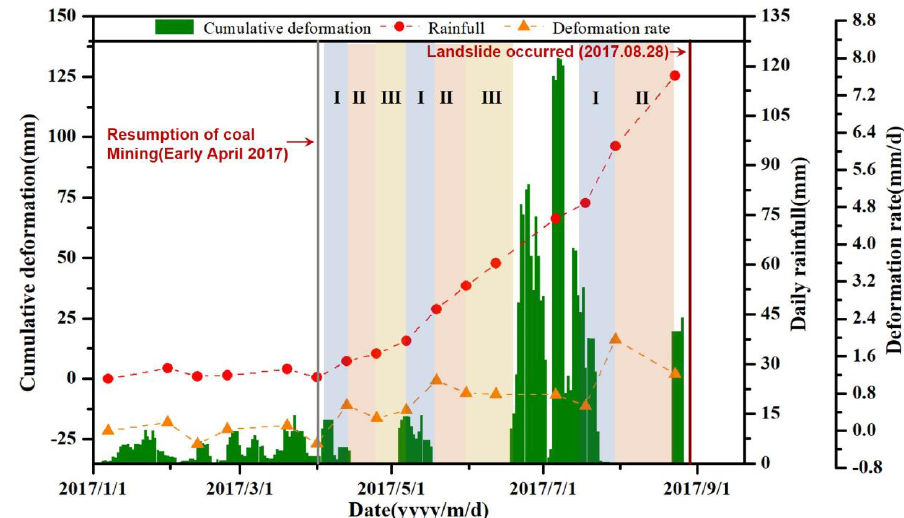
Figure 11. Comparison between cumulative deformation, cumulated rainfall amounts in five days, mining date, and deformation rate before the Pusa landslide occurred. The grey line indicates the date of resumption of coal mining, while the red line indicates the date of the landslide occurred. Shadow regions show different stages of deformation in the source area, which is influenced by weather variations.